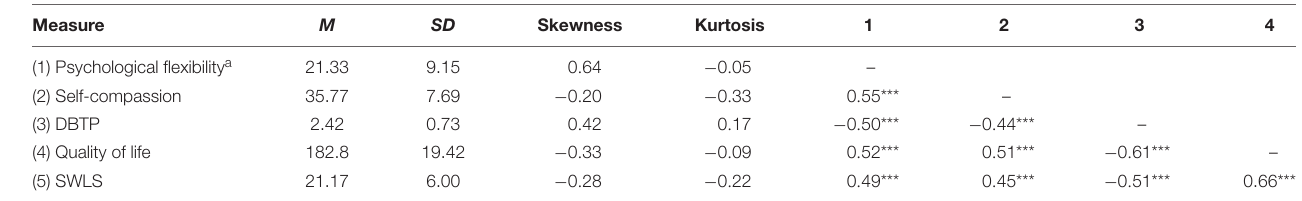
TABLE 1 | Descriptive statistics and zero-order correlations of study measures. Measure M SD